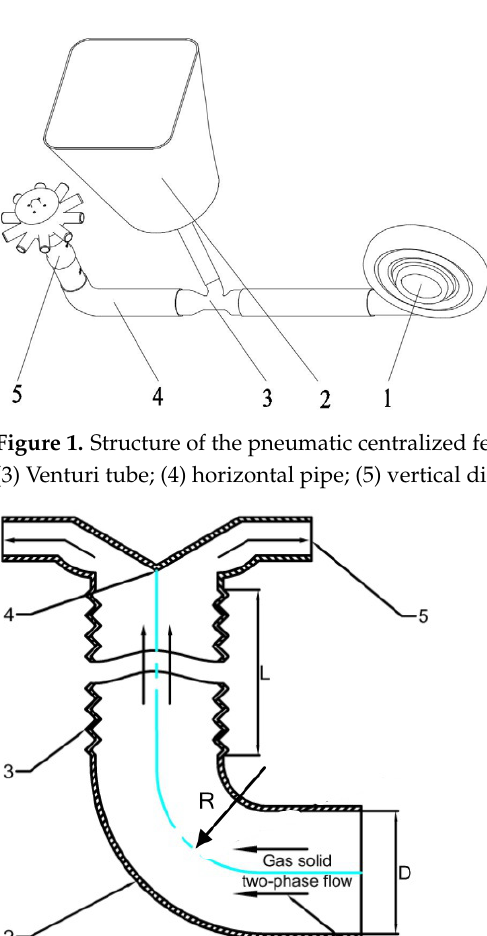
Figure 1. Structure of the pneumatic centralized fertilizer discharge system. (1) fan; (2) fertilizer box; (3) Venturi tube; (4) horizontal pipe; (5) vertical distributor.